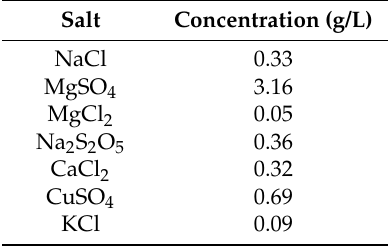
Table 3. Salt dosages for the saline water preparation at a total salt concentration of 5